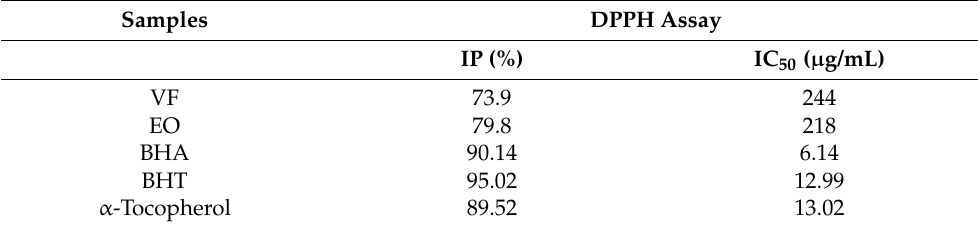
Table 3. Antioxidant activity of VF and EO expressed as IP% and IC 50 .